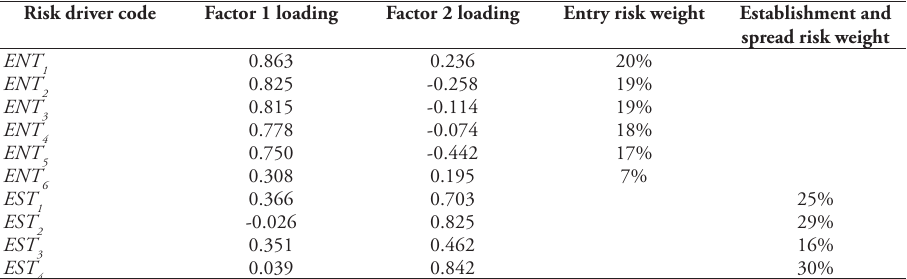
table 2. Rotated loadings of the risk drivers on two factor analysis axes, showing the contribution of each risk factor. See Table 1 for explanations of the risk driver codes. Relative loadings of entry drivers on factor 1 and of establishment and spread drivers on factor 2 were used as weights to estimate their combined